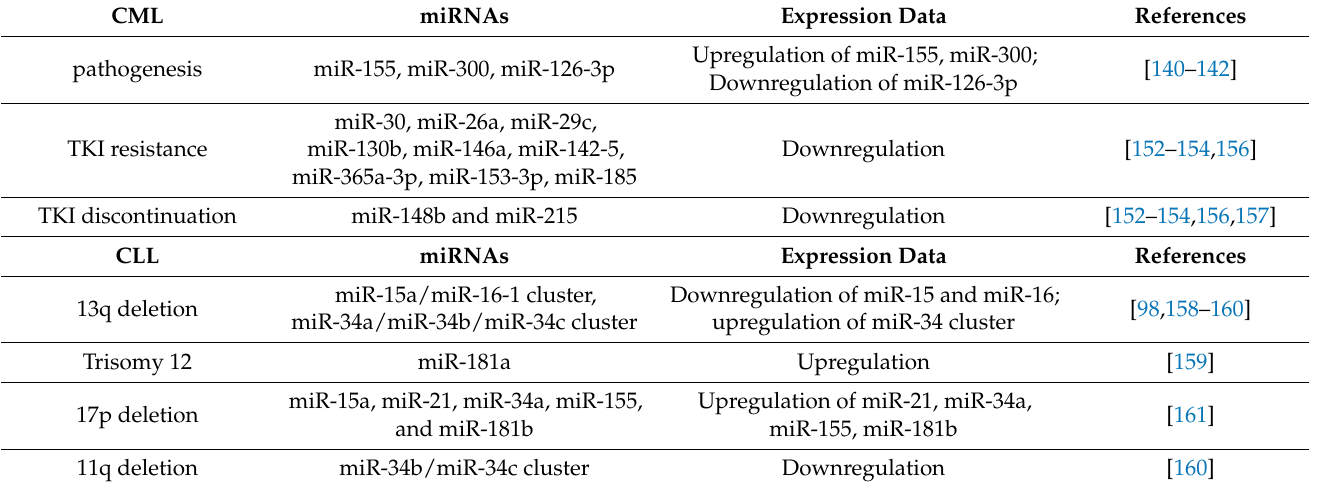
Table 2. miRNAs most frequently involved in chronic leukemia